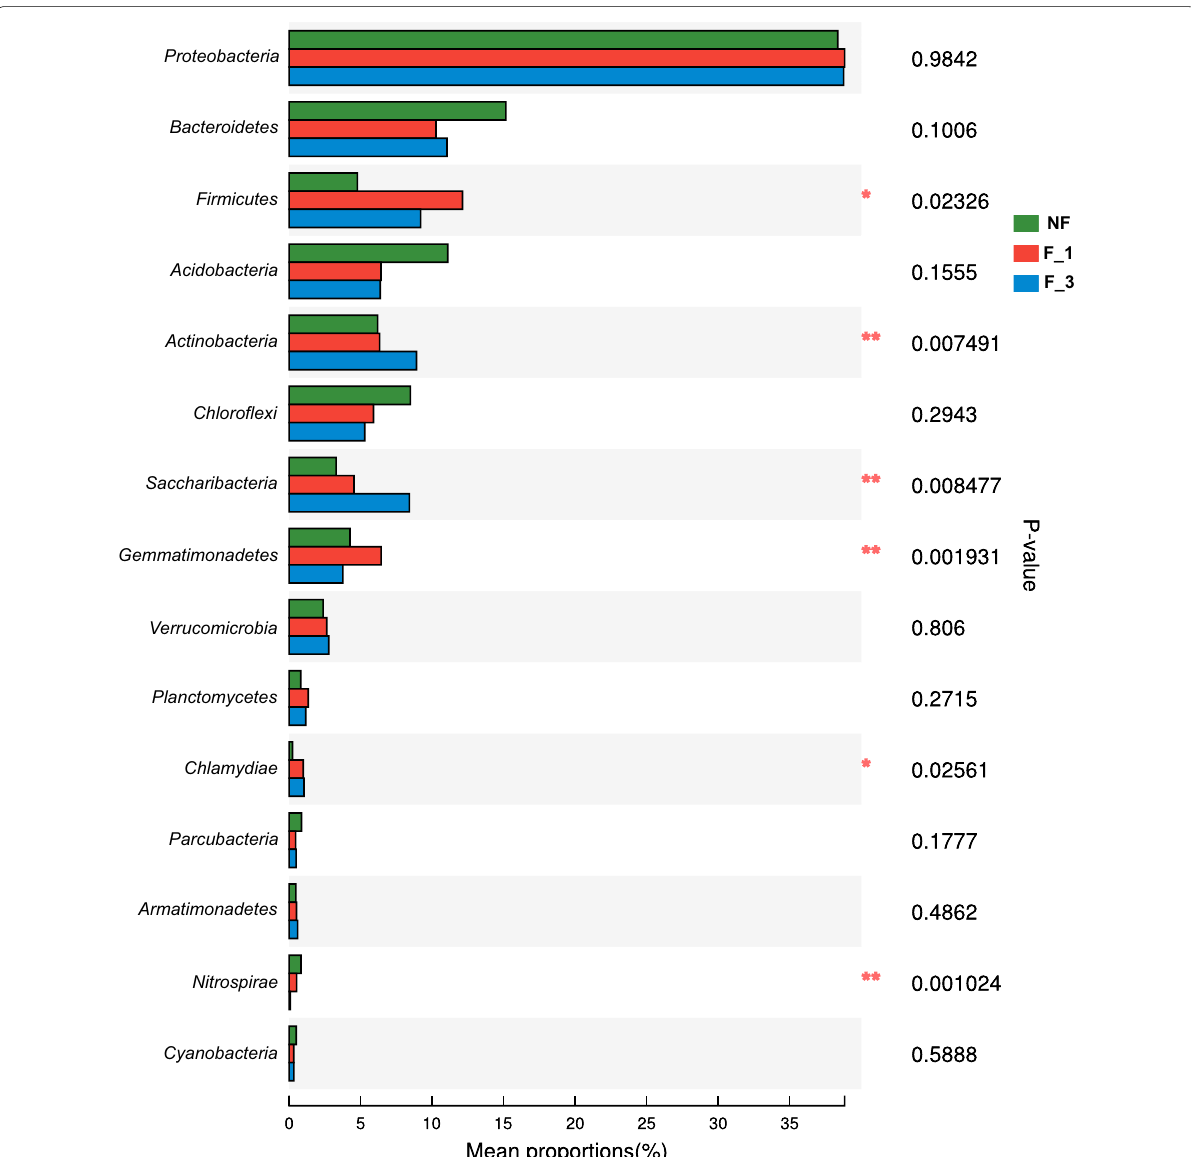
Fig. 2 Average relative abundance of the mainly abundant phyla within the different fumigation years (n (One-way ANOVA, P < 0.05; Multiple testing adjustment, FDR) in the different fumigation years. 0.01 < P P 0.001, three stars. NF non-fumigation, F_1 chloropicrin-fumigation for 1 year, F_3 continuous chloropicrin-fumigation for 3 ≤